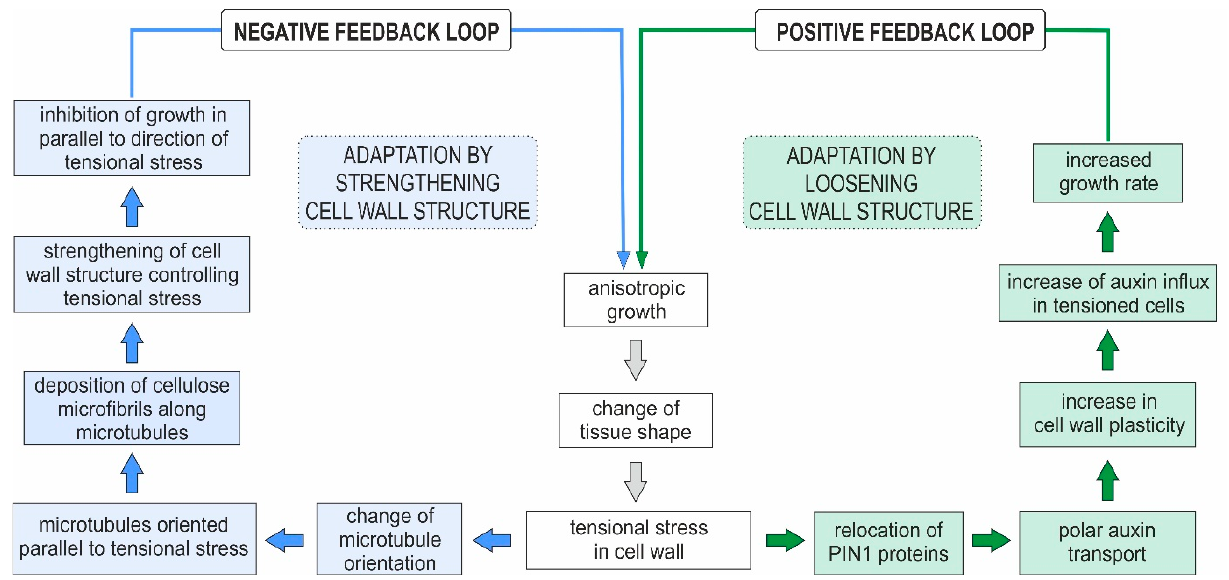
Figure 3. Proposed scheme showing positive and negative feedback loops that control plant cell growth (based on the literature cited in the main text). On the right is the green pathway associated with auxin action (polar auxin transport directed by PIN1 protein localisation). On the left (light blue), adaptation to mechanical stress leads to cell wall strengthening. Both feedback loops respond to a signal in the form of mechanical stress and control the growth of plant cells/tissues.